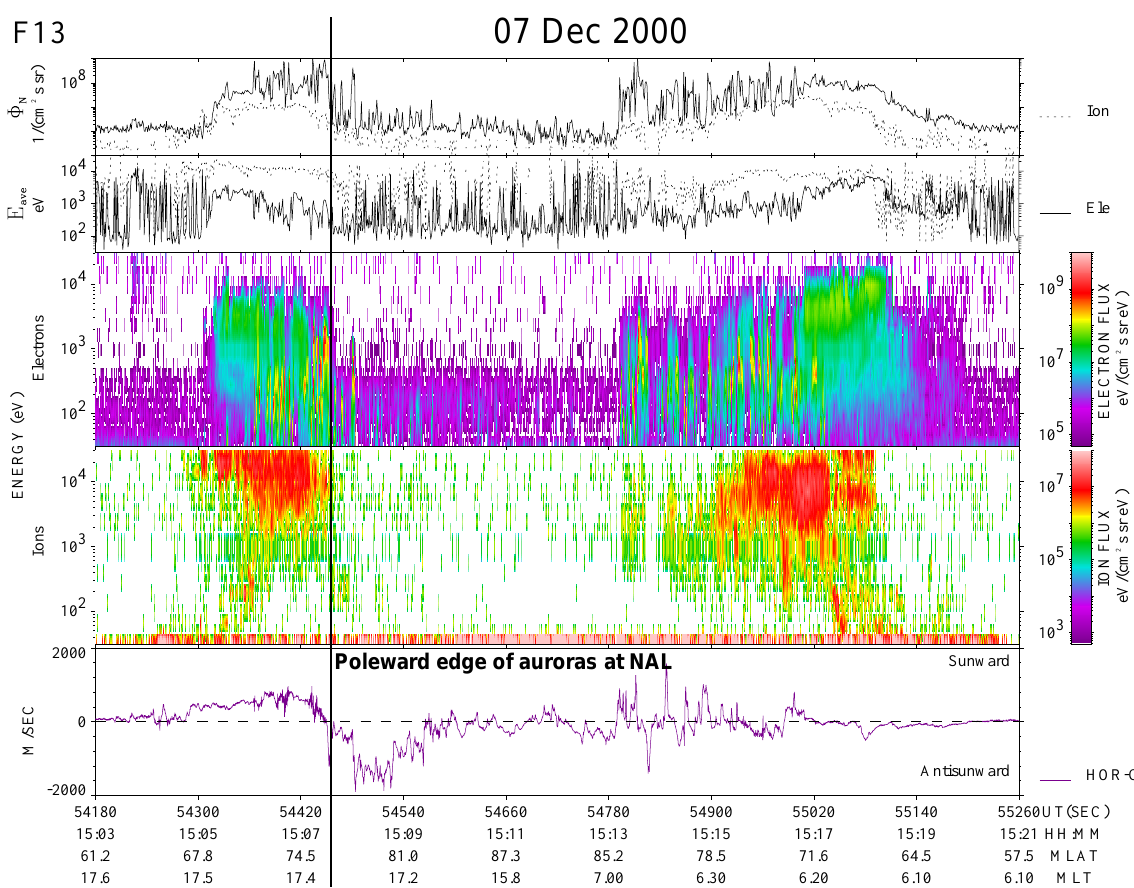
Fig. 6. Data recorded by DMSP F13 instruments during the track shown in Fig. 5 (from top to bottom): Ion and electron number fluxes and average energies, spectra showing differential energy fluxes, and plasma flow velocities. The vertical line marks the location of the poleward edge of the auroras shown in Fig.